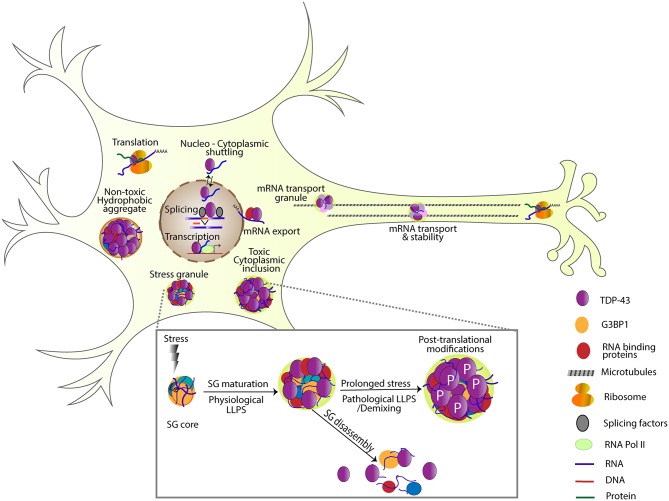
TDP-43 is involved in several steps of RNA processing including transcription, splicing, RNA stability, mRNA transport, localization, translation, and SG formation. Under transient stress, protein-protein and RNA interactions are nucleated by G3BP1, forming a dense SG core. TDP-43 and other RNA binding proteins are recruited to these cores and undergo liquid-liquid phase separation forming a dynamic shell structure (physiological LLPS). Under transient stress, SGs disassemble, and return these RNA binding proteins to their normal function. Under prolonged stress, TDP-43 undergoes post-translational modifications like phosphorylation, and becomes insoluble (pathological LLPS). Note non-toxic hydrophobic aggregates and toxic cytoplasmic inclusions as examples of different TDP-43 complexes that have been detected in cells (Bolognesi et al., 2019).